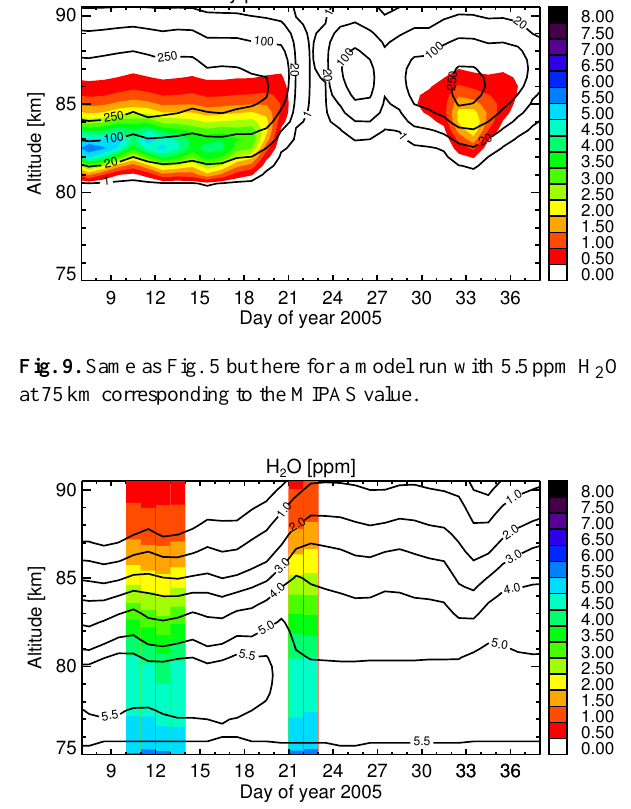
Fig. 10. Water mixing ratio [ppm] around the SPE January 2005 corresponding to Fig. 9. The filled color contours at days 10–13 and 21–22 show daily mean MIPAS water (70–80 ◦ S) and the contour lines show the model H 2 O smoothed with a 6km boxcar function to account for the vertical resolutions of the MIPAS